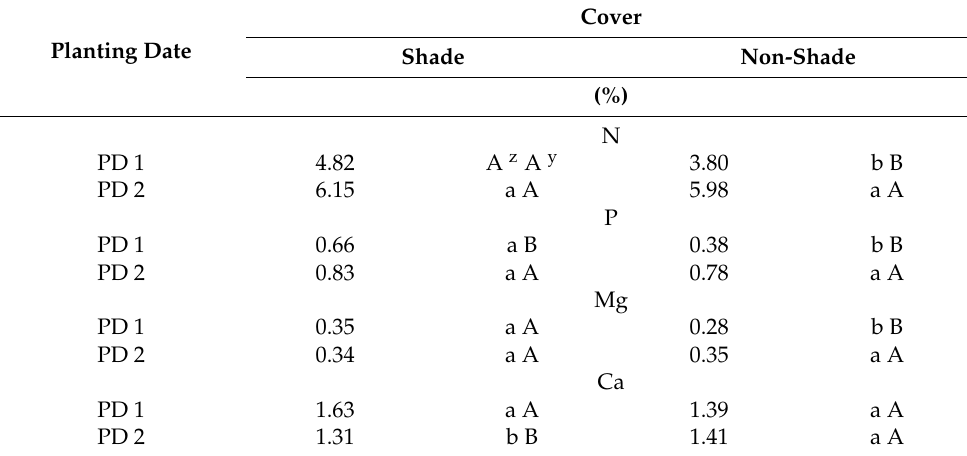
Table 2. Interaction between planting date (PD) and shading for foliar nitrogen (N), phosphorous (P), magnesium, (Mg), and Calcium (Ca) concentrations in high tunnel-grown lettuce ‘Salanova Red Butter’.